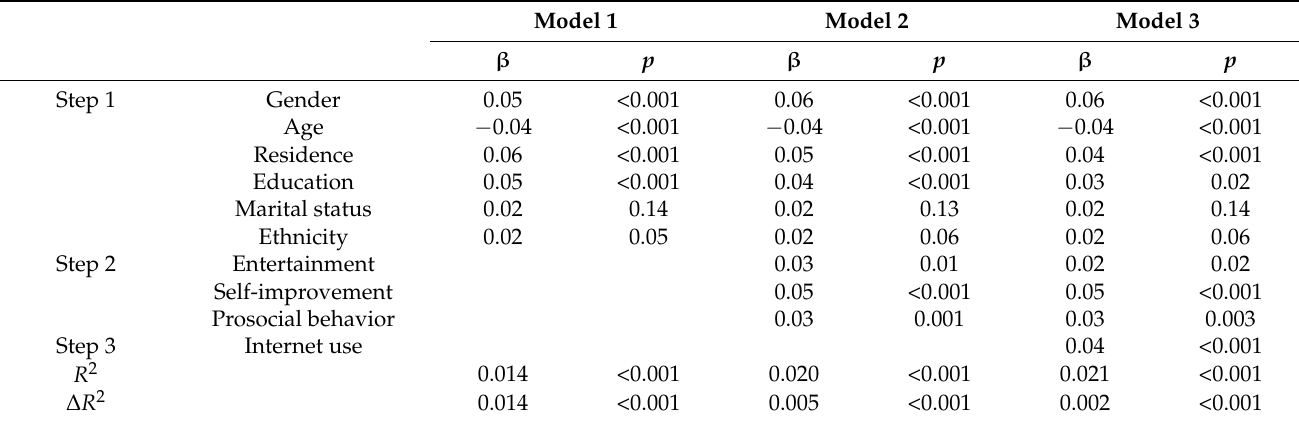
Table 6. Hierarchical regression analysis on health status in Sample 2 (N =